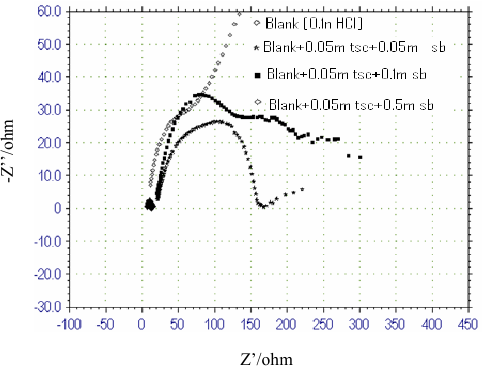
Figure 8 . Nyquiste plot of mild steel in 0.1 N HCl in absence and presence of various concentration of citrate and benzoate inhibitors Table 3. Electrochemical impedance parameter for the corrosion of mild steel in different concentration of HCl and in different concentration of inhibitors